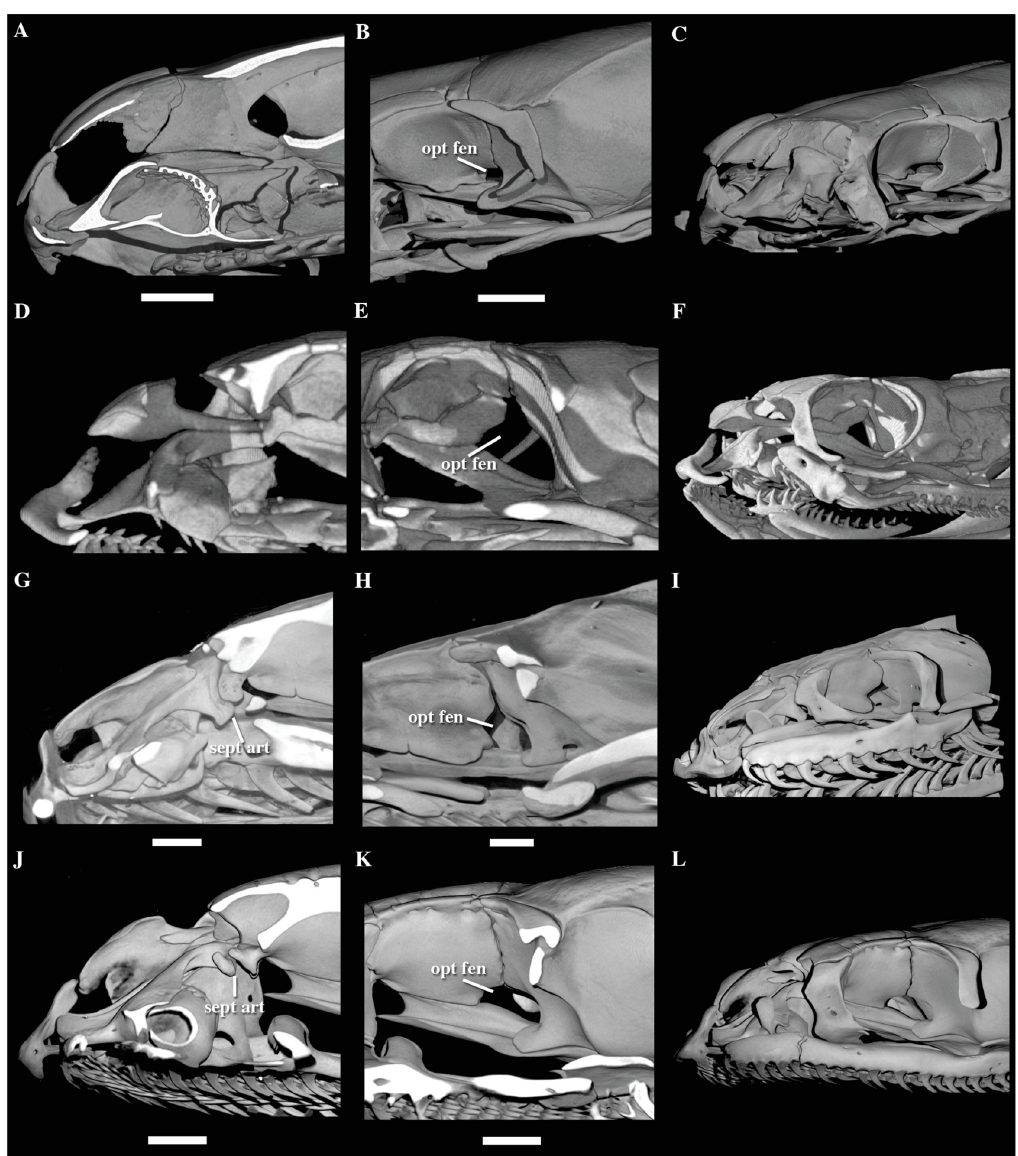
Fig 26. Skulls of Pareas moellendorffi (A-C), Causus rhombeatus (D-F), Enhydris chinensis (G-I), and Afronatrix anoscopa (J-L). Three-dimensional surface and cutaway views based on high resolution X-ray computed tomography. A, D, G, J left lateral three-dimensional cutaway views along the sagittal axis; B, E, H, K, left lateral three-dimensional surface views; C, F, I, L, oblique three-dimensional surface views. Legends: sept. art., septomaxillary articulation; opt. fen., optic fenestra. Scale bar = 1